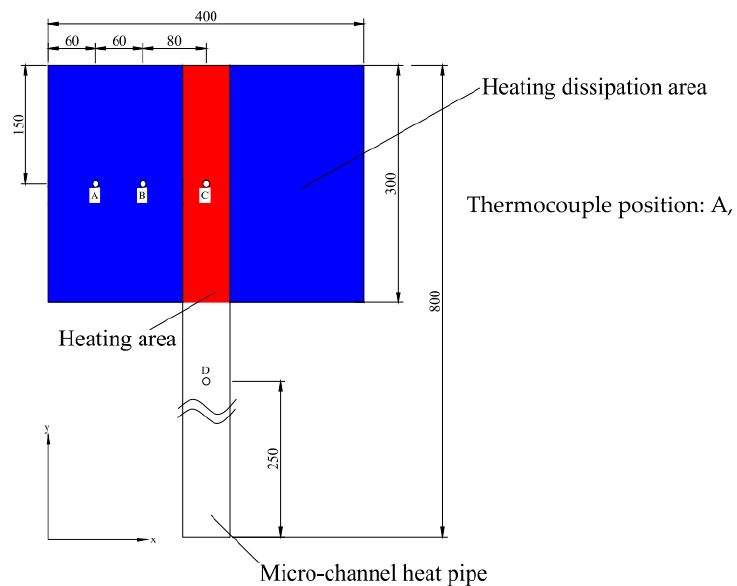
Figure 2. The dimensions of the radiative plate and the layout diagram of the thermocouple.